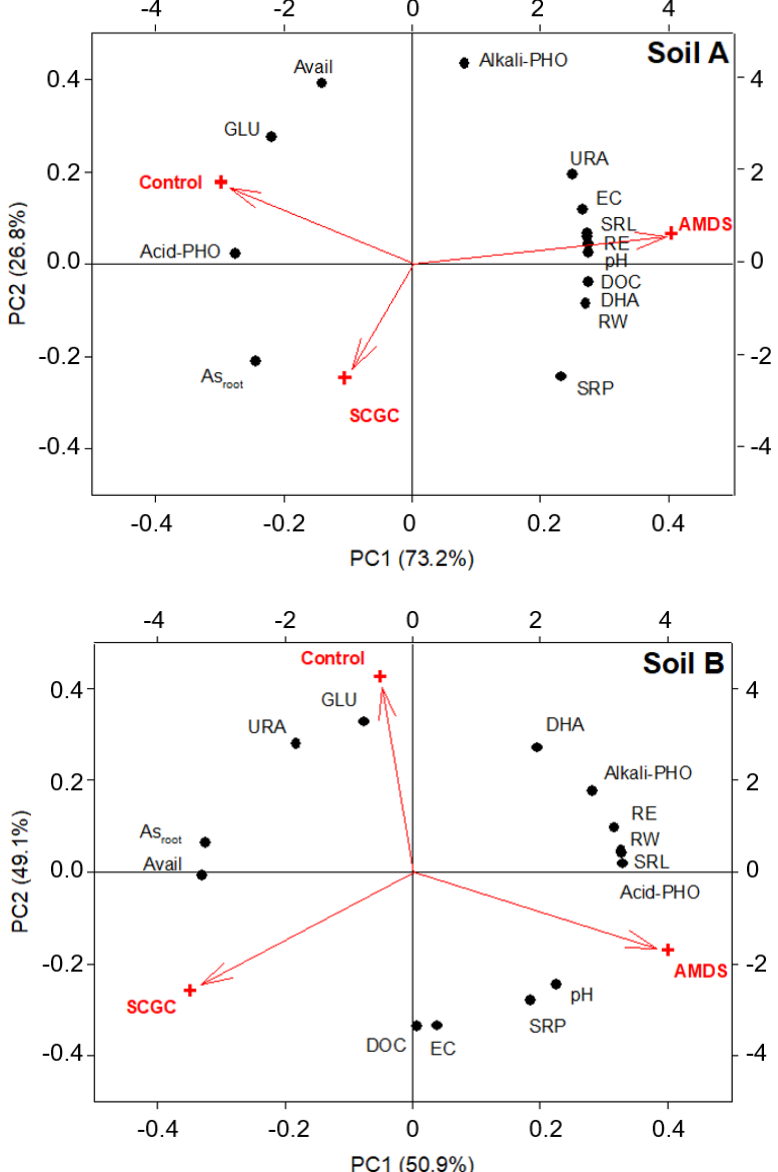
Figure 4. Distribution of the soil properties (EC, electrical conductivity; DOC, dissolved organic carbon; Avail, bioavailability of As), phytotoxicity results (root length; root weight; RootAs, As concentration in root), soil biological properties (SRA, soil respiration activity; DHA, dehydrogenase activity; URA, urease activity; GLU, ß-glucosidase activity; Acid-PHO, acid phosphatase activity; Alkali-PHO, alkali phosphatase activity), and ecological properties (OTU, operational taxanomic unit; shannon, simpson) of two soils plotted against the first and second principal component (PC) from principal component analysis.